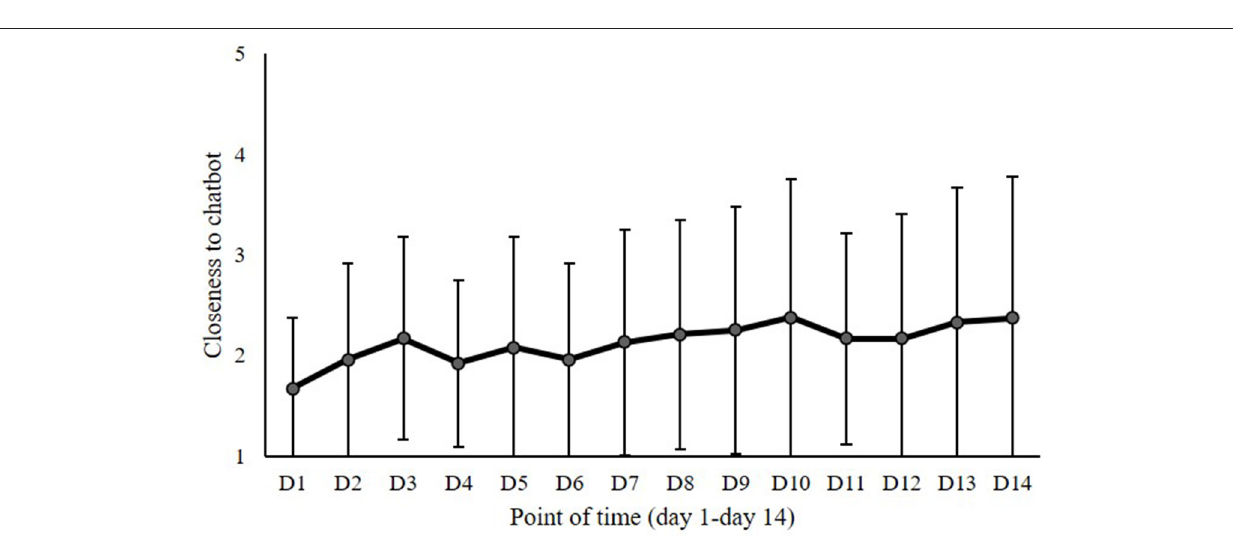
FIGURE 4 | Perceived closeness to the chatbot over the 2-week study period (Day 1–Day